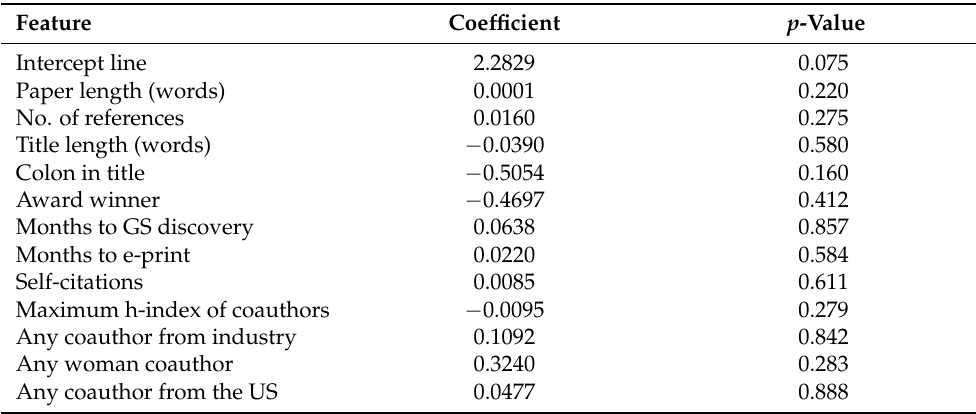
Table 3. Generalized linear model of log-citations as a function of paper